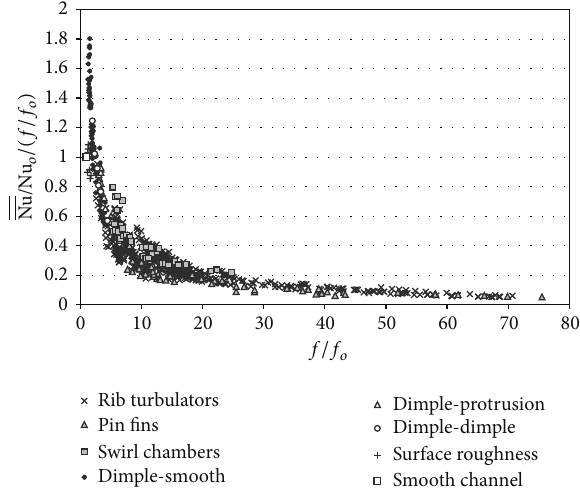
Figure 5: Comparison of relative performance of rib turbulators, pin fins, swirl chambers, dimple-smooth arrangements, dimple- protrusion arrangements, dimple-dimple arrangements, surface roughness, and smooth-walled channels from investigations prior to 2003. Globally averaged thermal performance parameters Nu / Nu 𝑜 /(𝑓/𝑓 𝑜 ) are presented as dependent upon friction factor ratios 𝑓/𝑓 𝑜 [1].